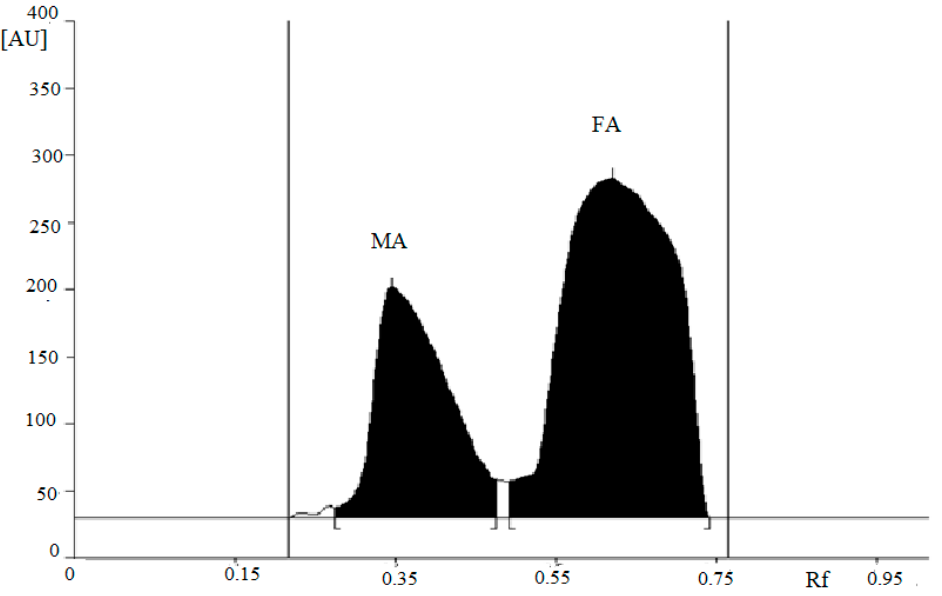
Figure 2. Densitogram of the mixture of fumaric acid (FA) and maleic acid (MA) after extraction in the n -octanol–water system and separation by NP-TLC.